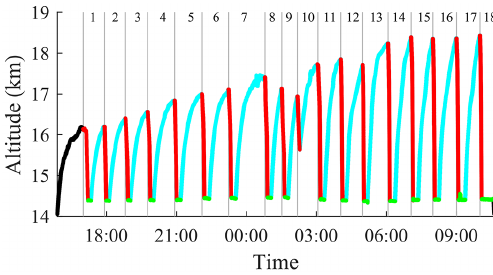
Figure 8. Altitude of Global Hawk on RF05 as a function of time. The flight has been divided into sections, numbered at the top of the plot; these numbers correspond to the section or profile numbers in Figs. 11, 12 and